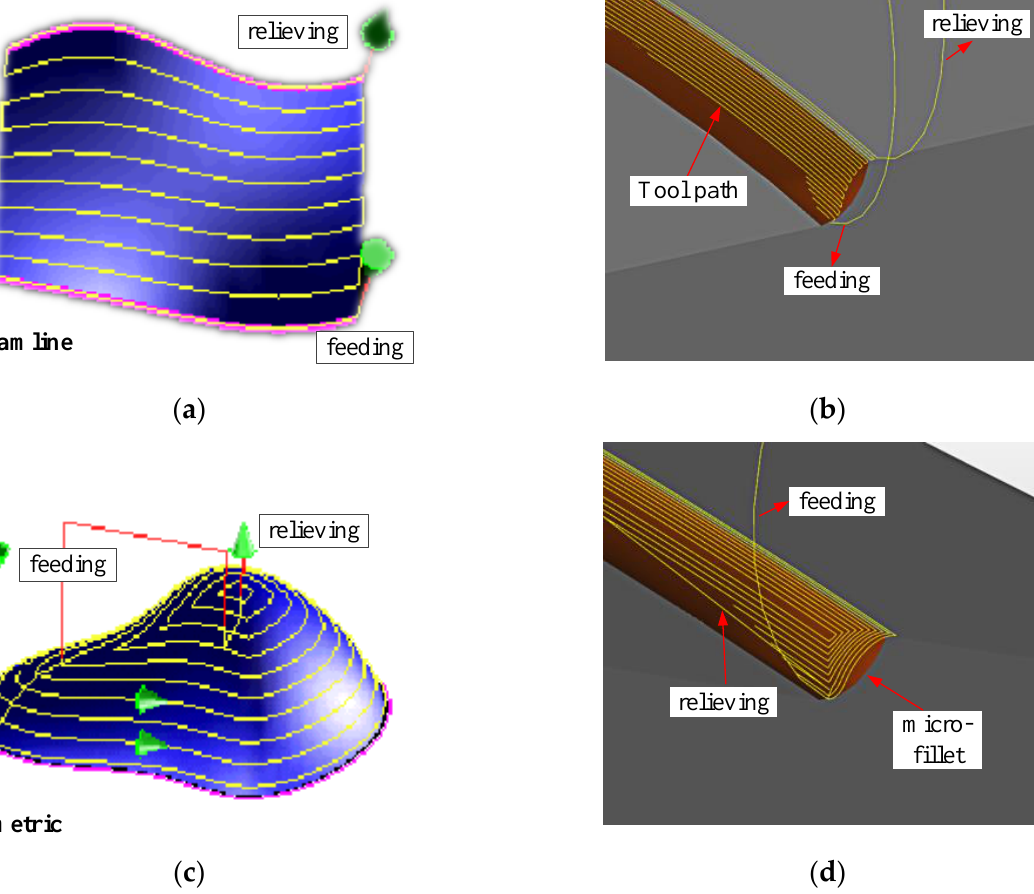
Figure 8. ( a ) Streamline machining strategy, ( b ) tool path of streamline machining strategy, ( c ) isometric machining strategy and ( d ) tool path of isometric machining